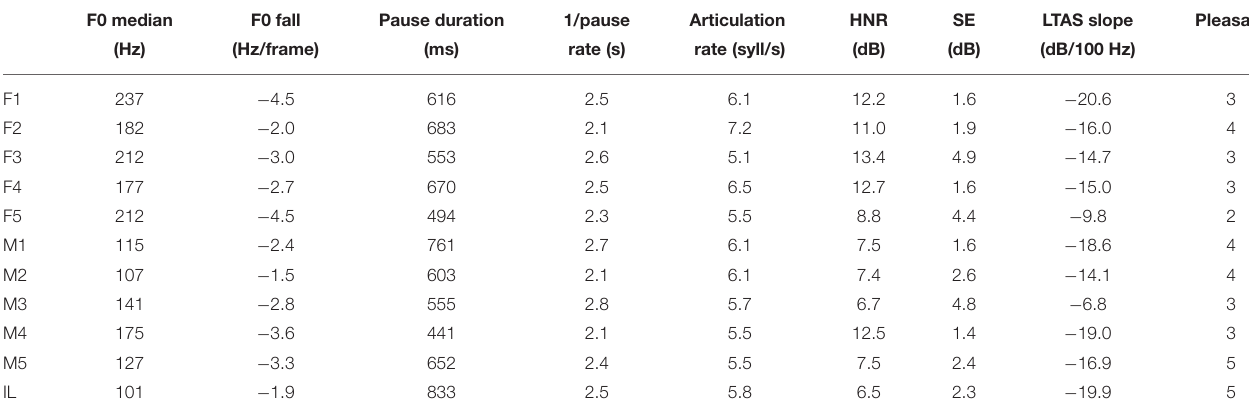
TABLE 3 | Mean values for significant predictors for Brazilian reciters (gender indicated by the first letter: F, female; M,